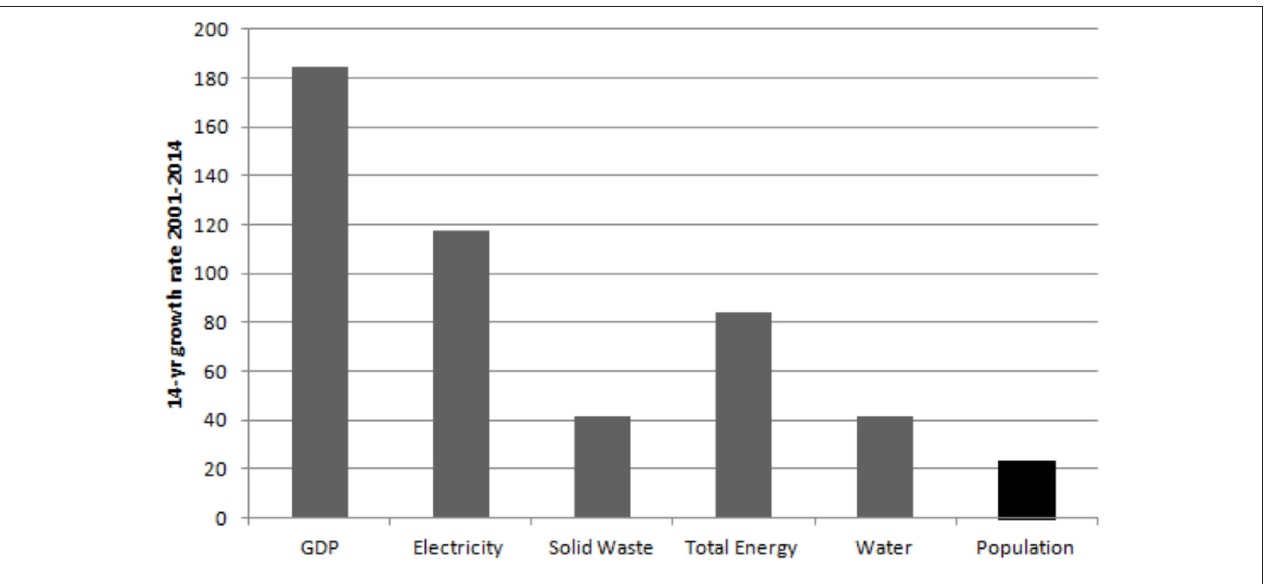
FIGURE 1 | Percent growth of metabolic flows in the period 2001–2014.